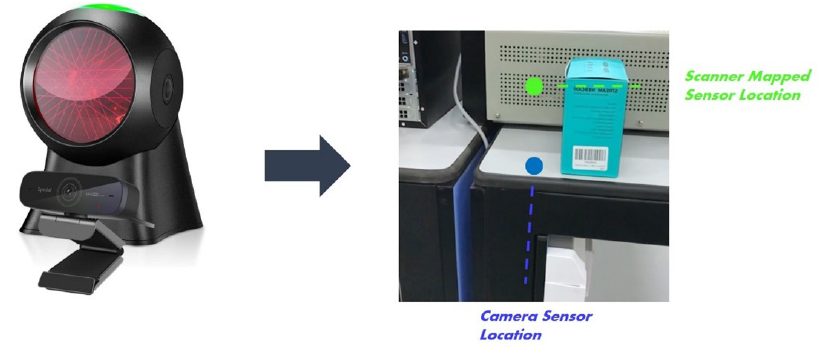
Figure 13. Mapping the centers of the camera and scanner